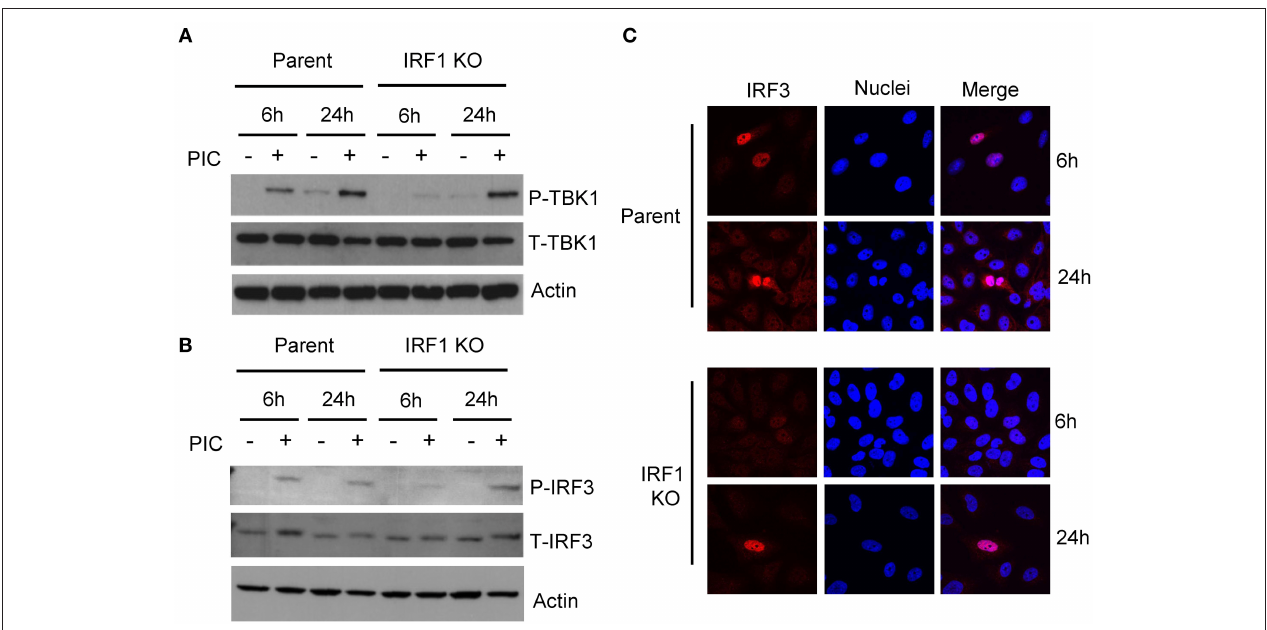
FIGURE 3 | IRF1 is required for optimal early activation of TBK1 and IRF3. Parent BEAS-2B and IRF1 KO cells were transfected with poly I:C and were harvested to measure activation of TBK1, with anti-pTBK1 S172 antibody (A) and IRF3 with anti-pIRF3 Y396 antibody (B) at 6h and 24h by immunoblot. (C) IRF1 KO and parent cells were transfected with poly I:C and cells were fixed and immunostained for IRF3. Representative confocal microscopic images are